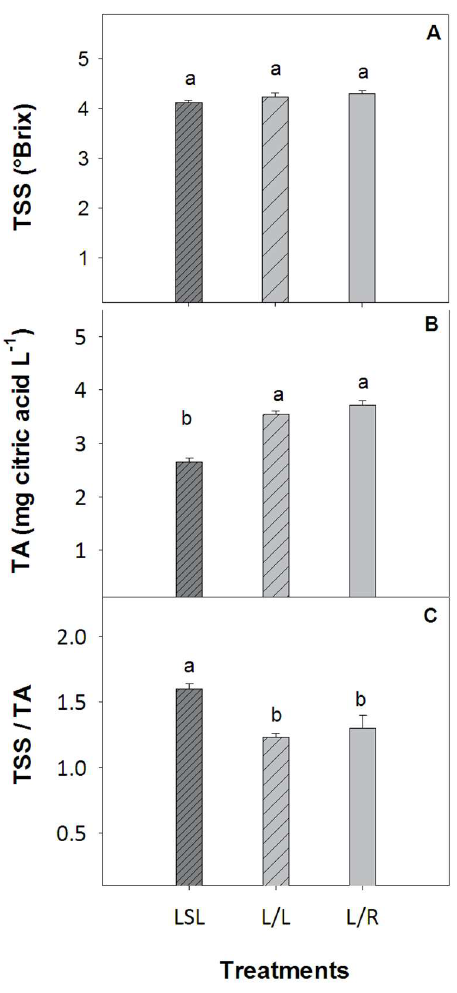
Figure 9. Total soluble solids (TSS, °Brix) ( A ), titratable acidity (TA, mg citric acid L −1 ) ( B ) and ratio TSS/TA) of the fruit ( C ) by treatments LSL (long-shelf-life tomato), L/L (self-grafted Old Limachino tomato) and L/R (grafted Old Limachino tomato on Poncho Negro rootstock) under greenhouse conditions. Each value represents the mean ± SE ( n = 12). Lower-case letters indicate differences ( p ≤ 0.05, Duncan test) among treatments.